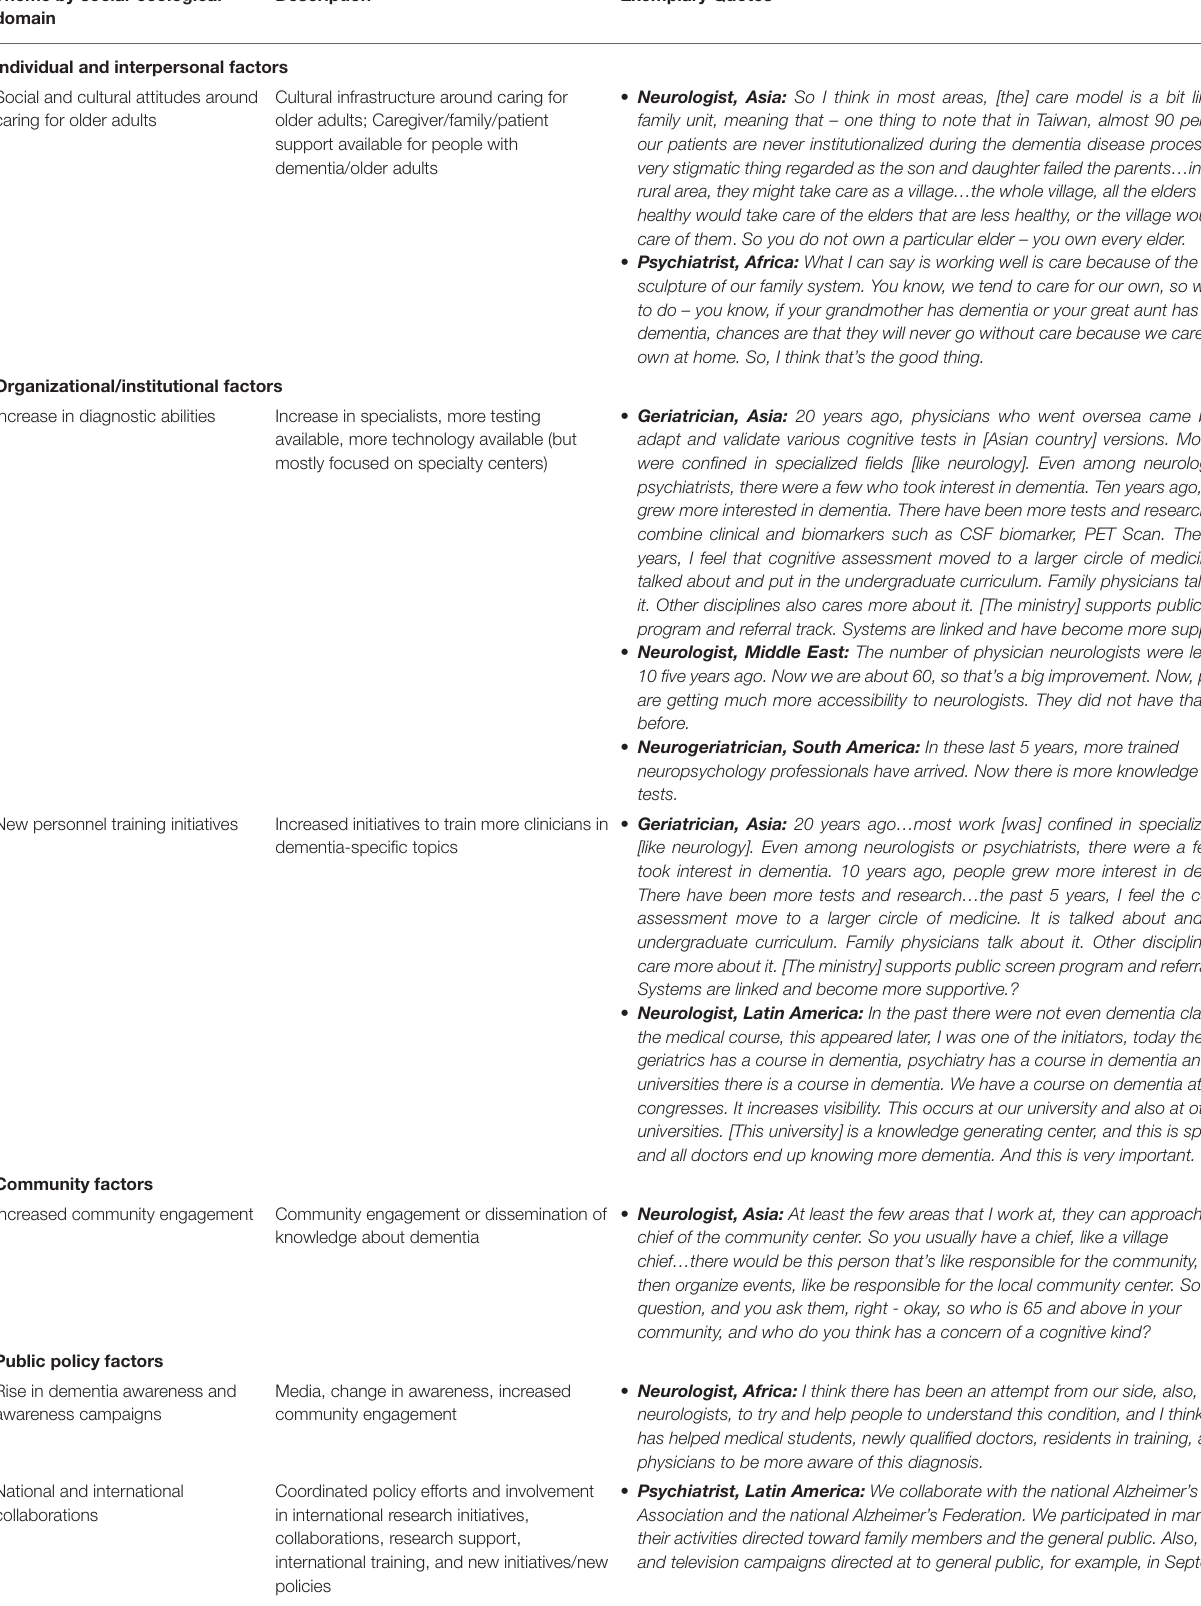
TABLE 4 | Facilitators to dementia assessment and